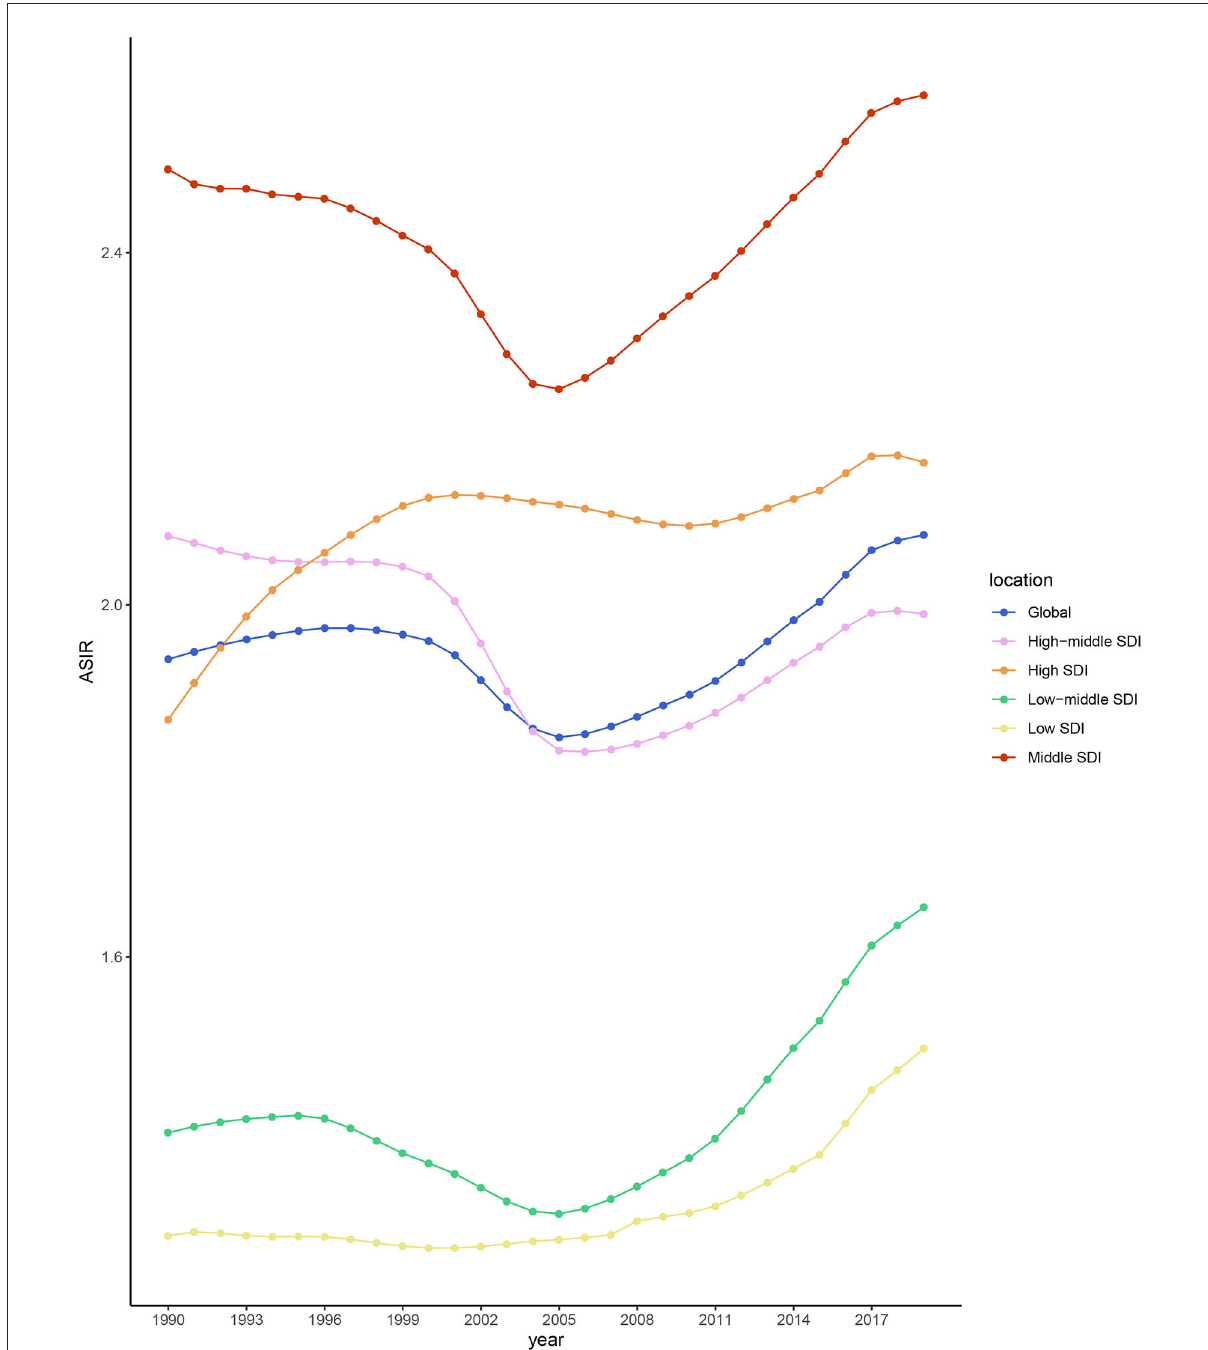
FIGURE2 ASIR differences between different SDI subgroups from 1990 to 2019.